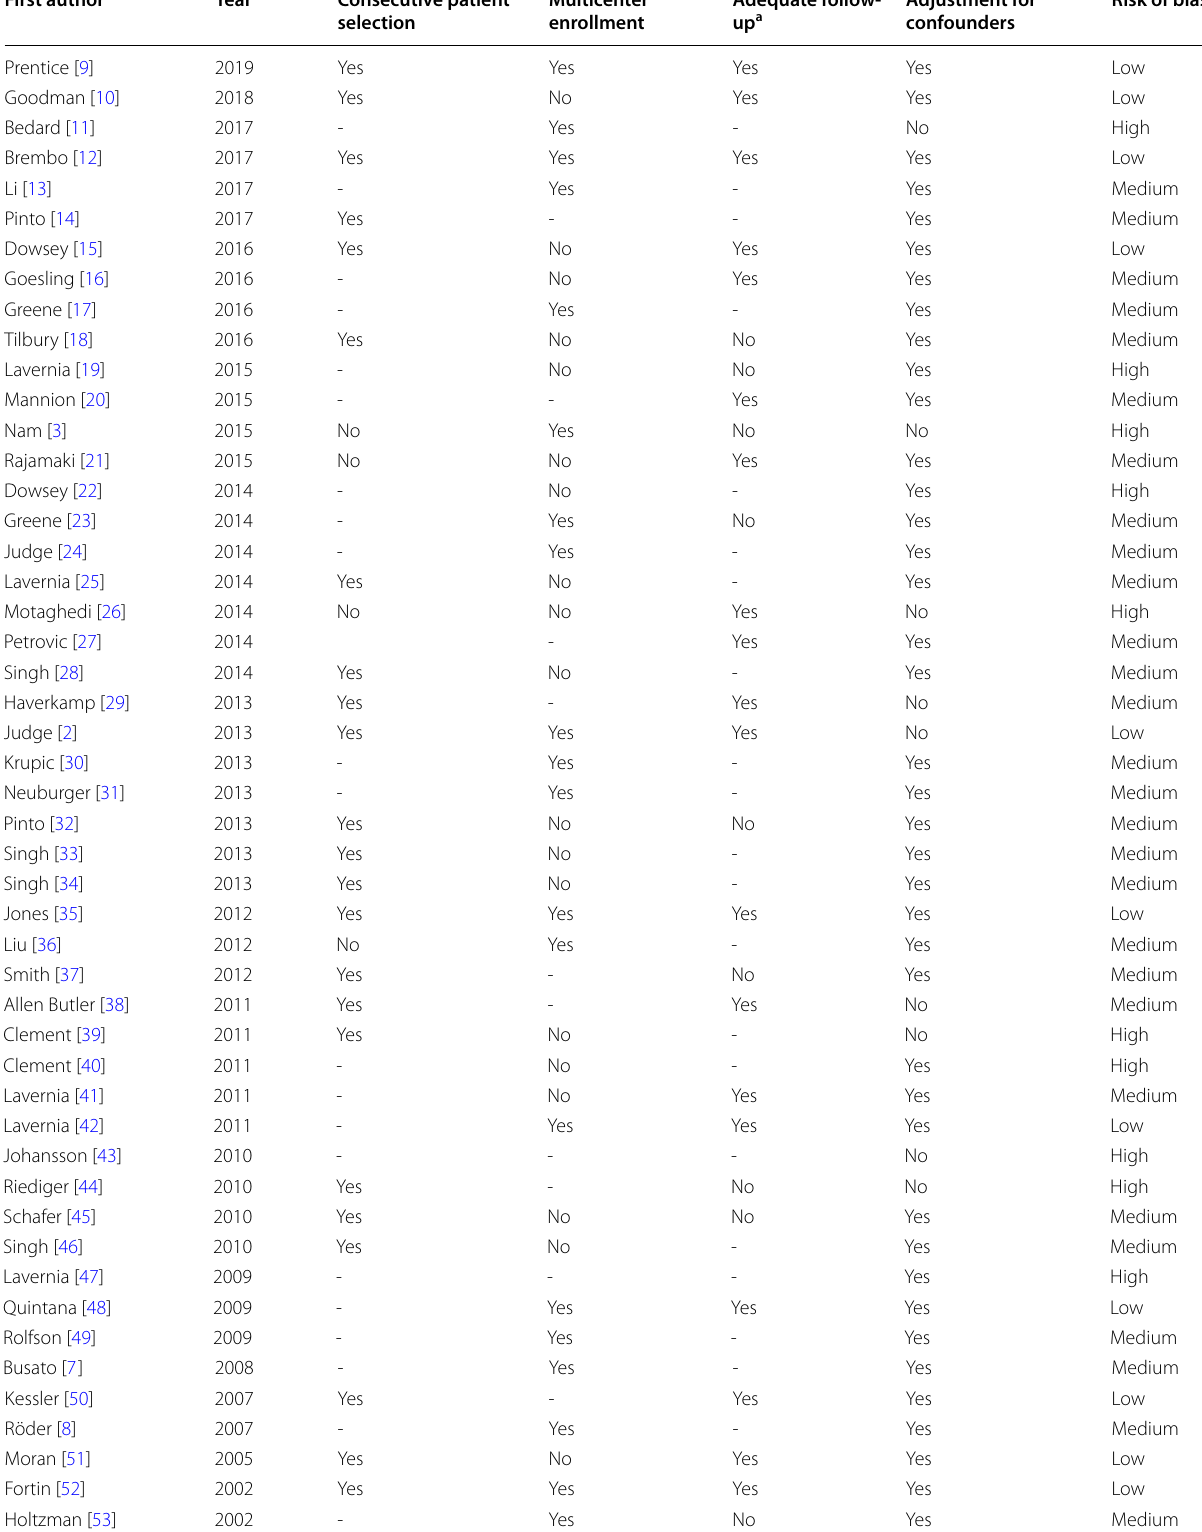
Table 1 Risk of bias among 53 studies of adult